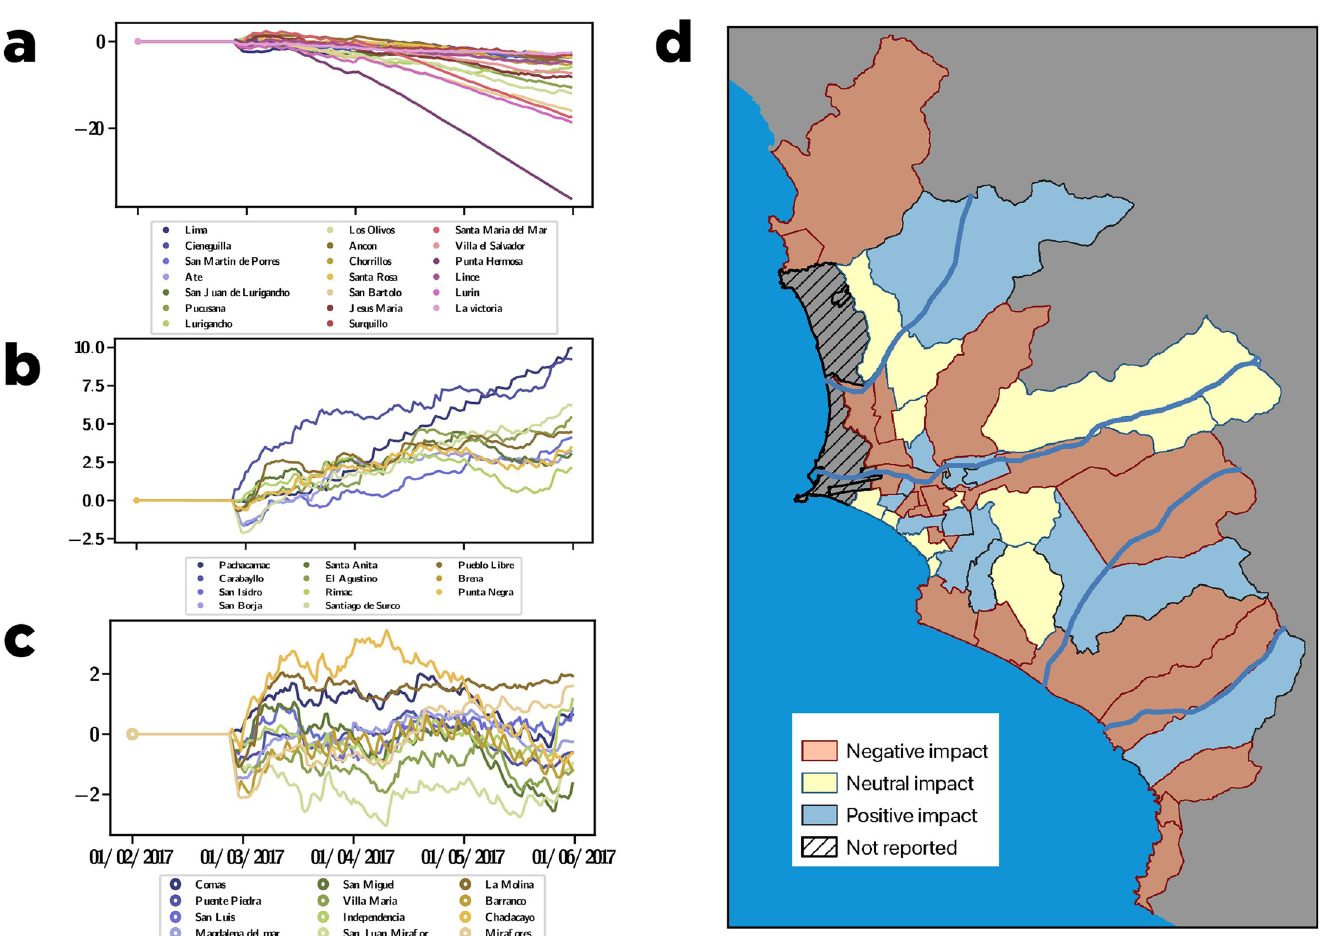
Fig 3. Causal impact at the districts level for February 2017. a ) List of districts that were negatively impacted. b ) List of districts that were positively impacted. c ) List of districts that experienced a neutral impact. d ) Map of Lima showing the districts with a negative (red), positive (green) and neutral (yellow) impact.